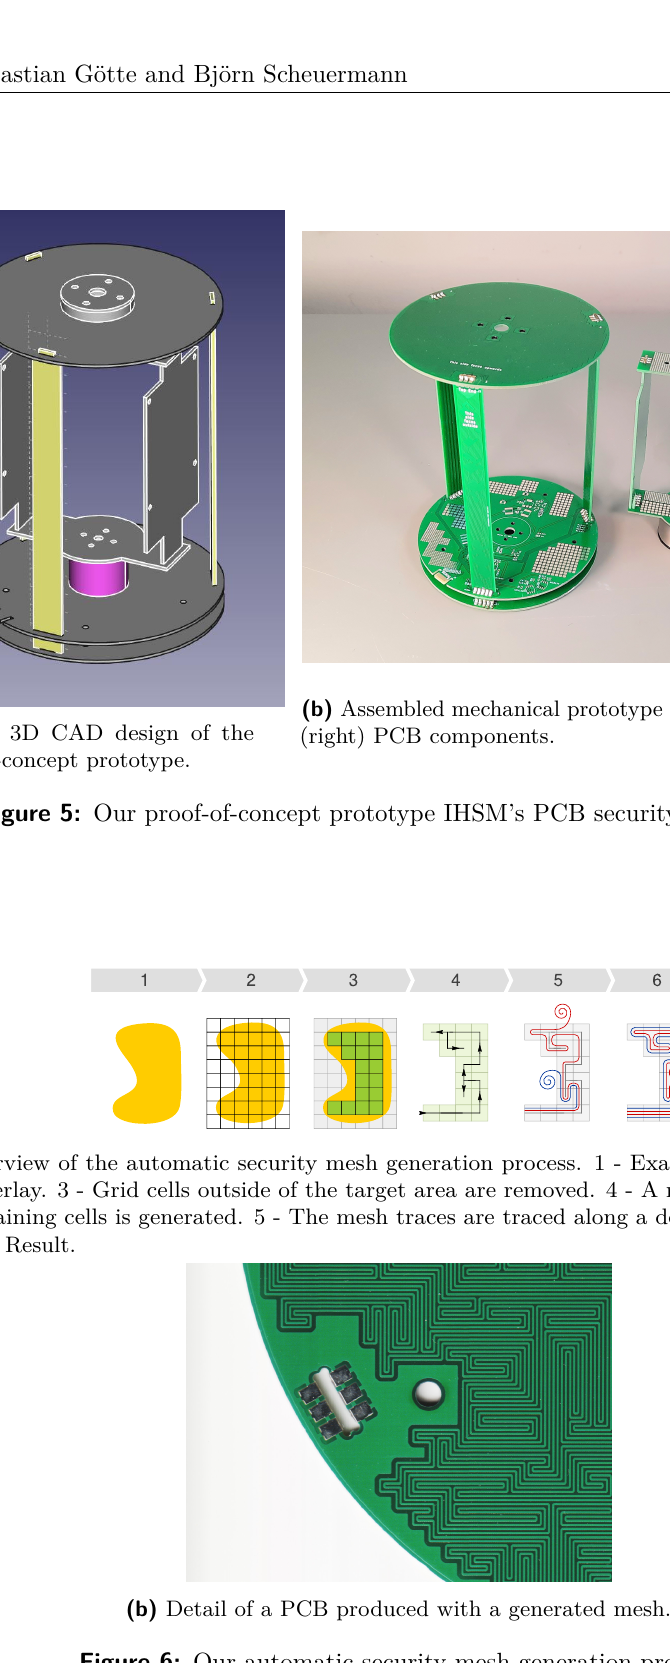
Figure 6: Our automatic security mesh generation